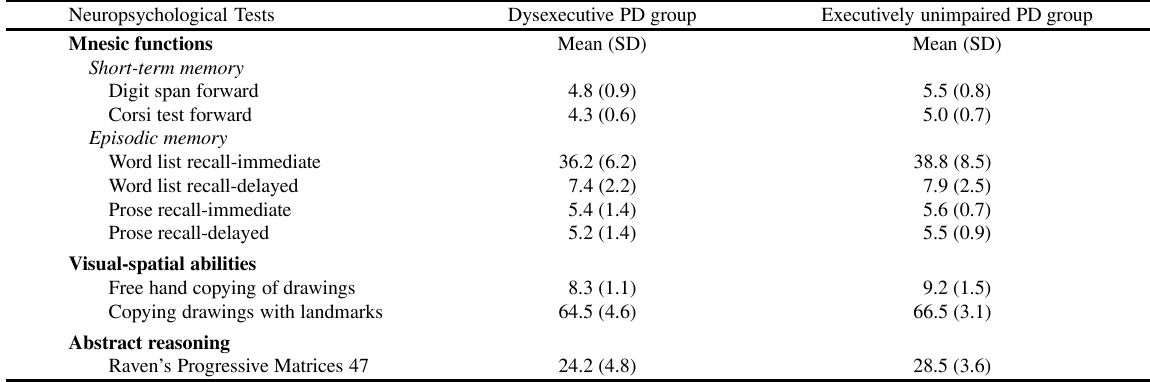
Table 3 Performance of PD patients (i.e. average scores and percentage of pathological values) on the neuropsychological test